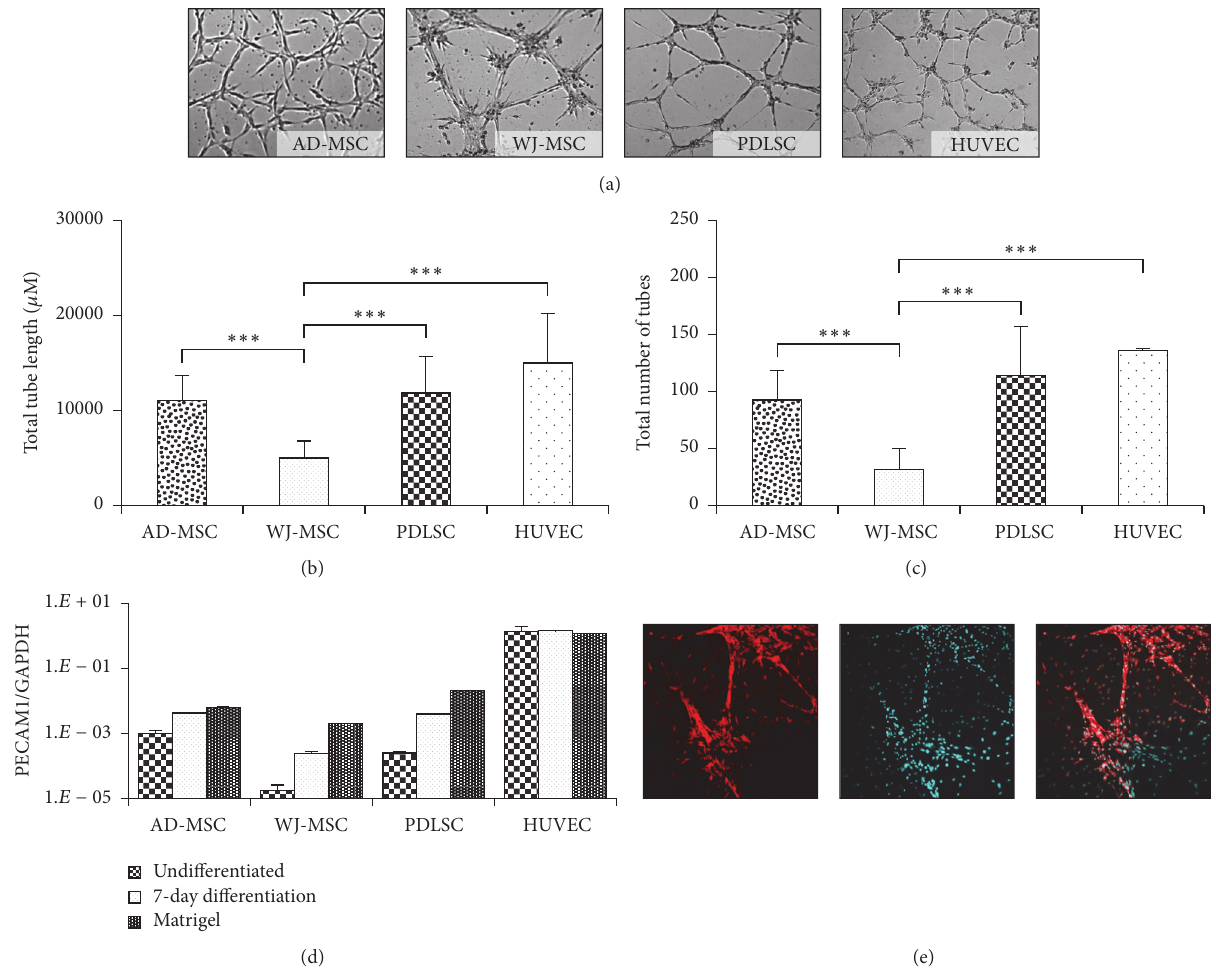
Figure 4: Endothelial differentiation potential of the MSCs was tested in Matrigel tube formation assay. Tubular-like structures were photographed (a) and analyzed with TubeCount software. Human umbilical vein endothelial cells (HUVEC) were used as controls. Total tube length (b) and numbers (c) were counted and presented in the diagrams. The changes in the expression of PECAM1 during endothelial differentiation were followed with RT-qPCR. Samples were collected from undifferentiated and predifferentiated states (7-day endothelial induction) and after angiogenesis in a Matrigel assay (d). The 3D network developed by a representative PDLSC sample was demonstrated with fluorescence staining of the cell membrane by DiSC 3 (5) (red) and the nucleus by DAPI (cyan) (e). The photos demonstrate representative samples. ∗∗∗ 𝑃 value less than